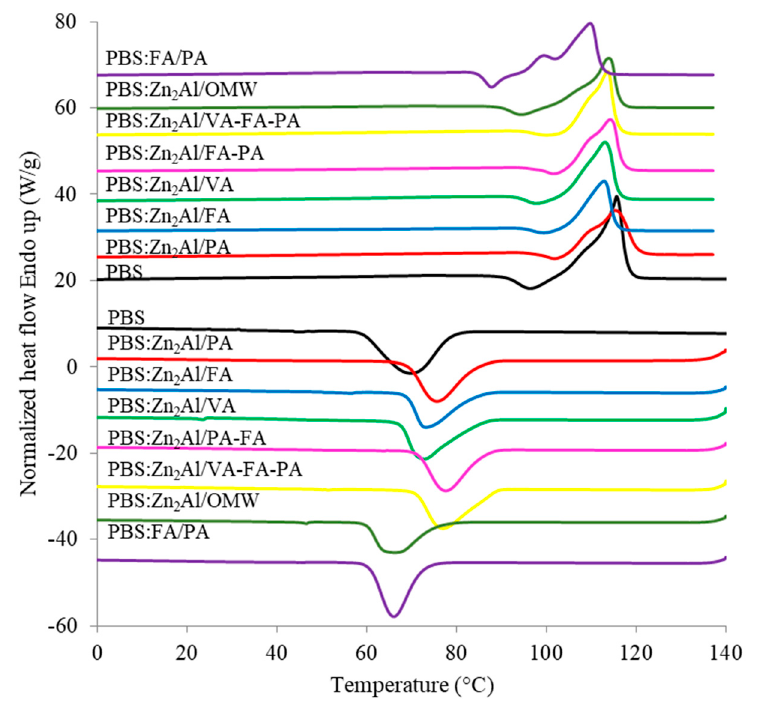
Figure 3. DSC profiles of PBS, PBS:FA/PA, and PBS:Zn 2 Al/X composites.